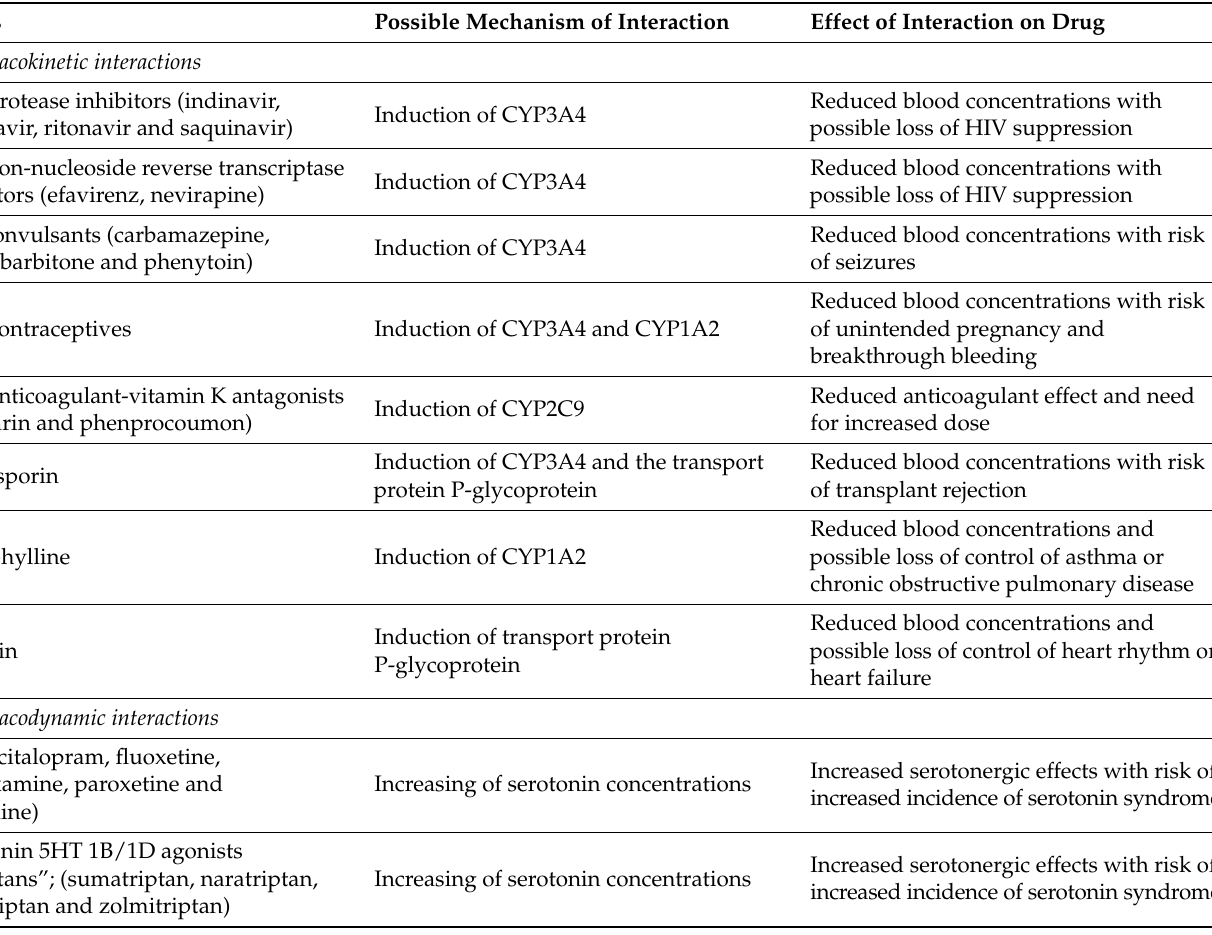
Table 2. Clinically significant interactions of St. John’s wort with